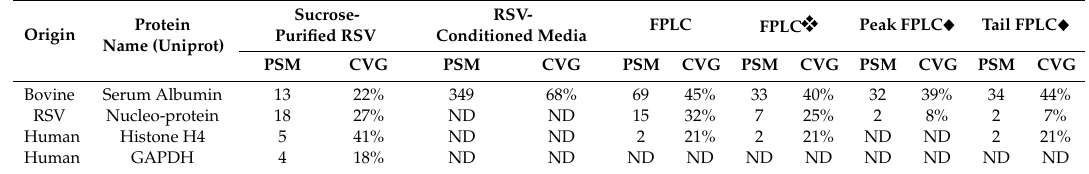
Table 2. Mass spectrometry summary of RSV purification